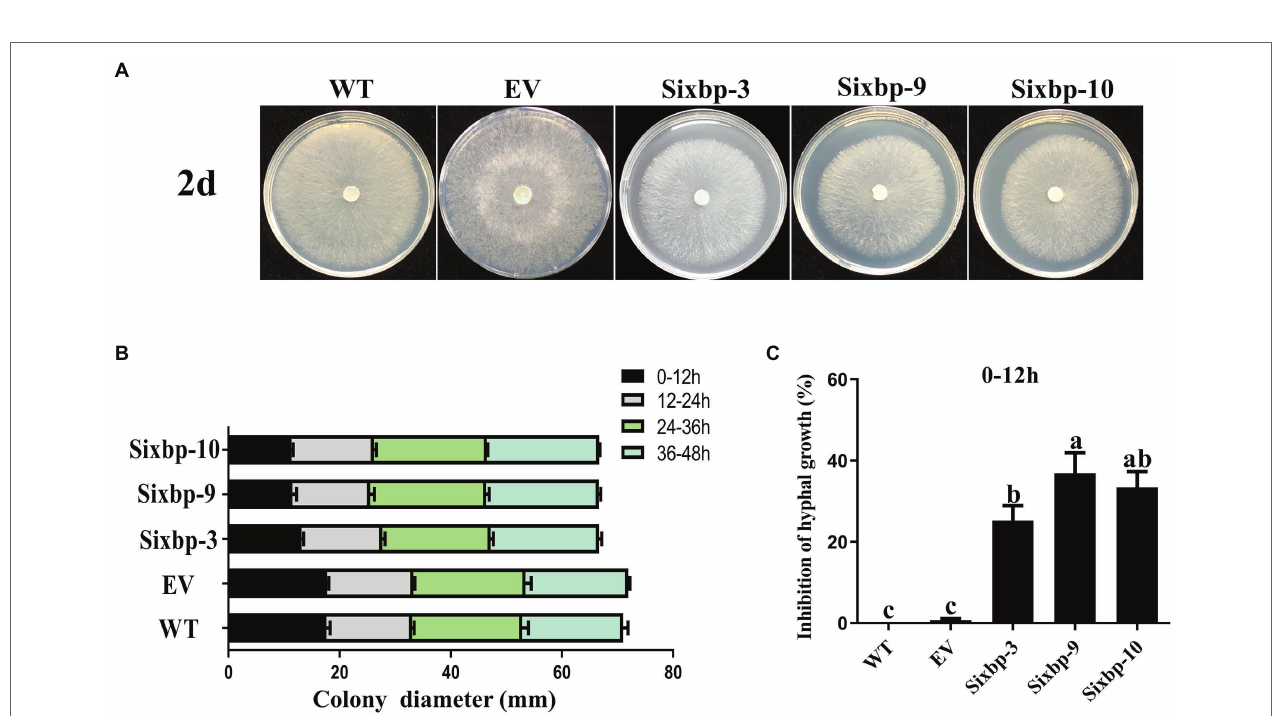
FIGURE 2 | Relative expression levels of CsXbp1 in different tissues (A) and during infection (B) as assessed by quantitative real-time PCR (qRT-PCR). The β -tubulin gene was used as the internal control to normalize the expression levels. Different letters above bars represent significant differences ( p < 0.05) as determined with using a one-way Duncan’s test. The analyses were repeated three times. Each time was investigated with three Nicotiana benthamiana leaves. Gene expression levels in different replicates showed similar trends.